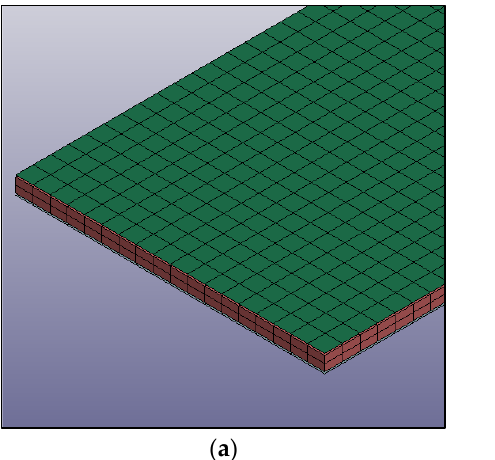
Figure 22. ( a ) Finite element model with shell-solid-shell elements for the skin-core-skin and ( b ) Shape of sandwich laminate after springback.